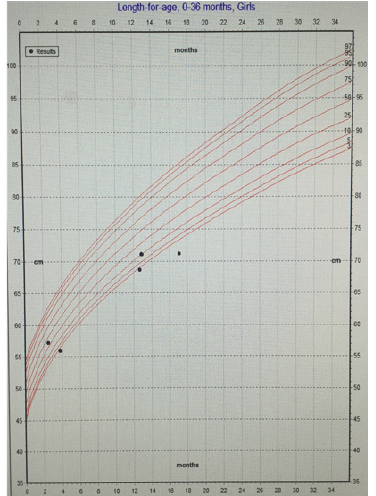
Figure 5: Patient’s growth chart—length for age.